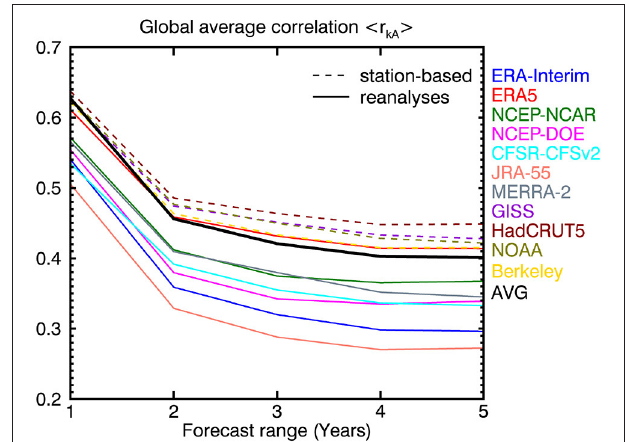
r kA between ensemble h i